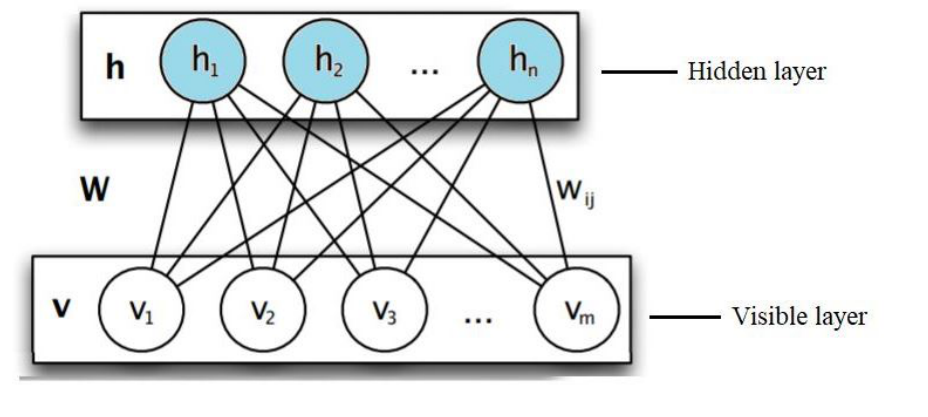
Figure 1. The structure of